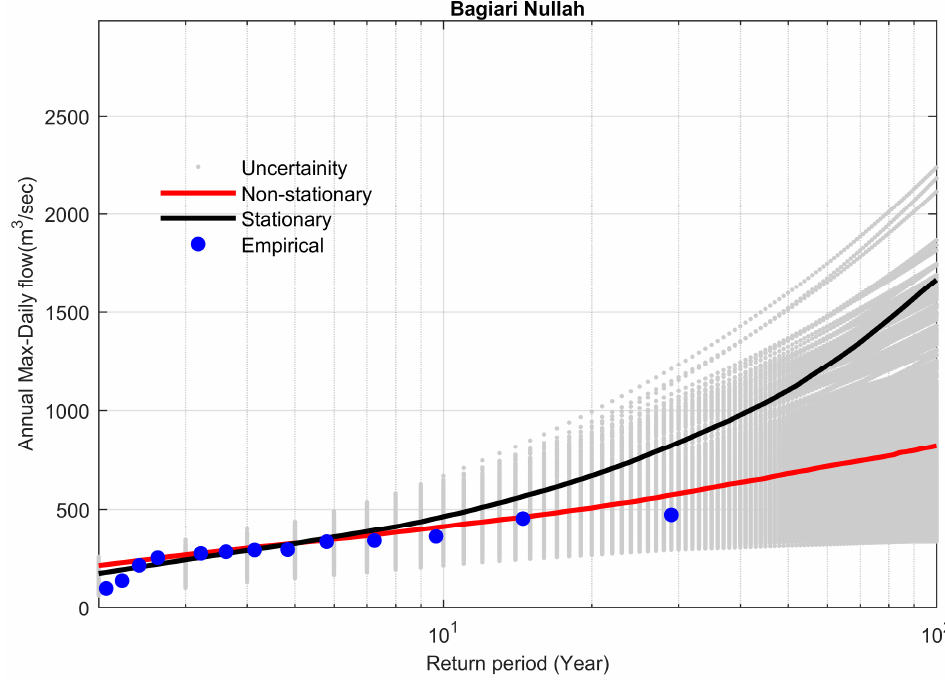
Figure 6. Comparison between non-stationary and stationary FFCs at site 21, along with non-stationary uncertainty bounds for the year 2016.